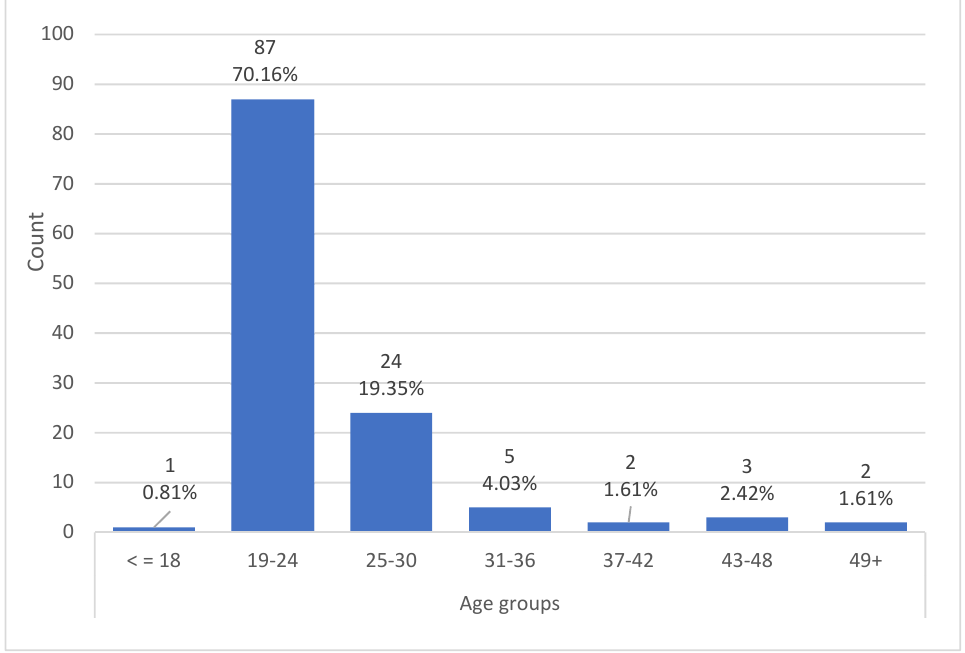
Figure 2. Age groups.